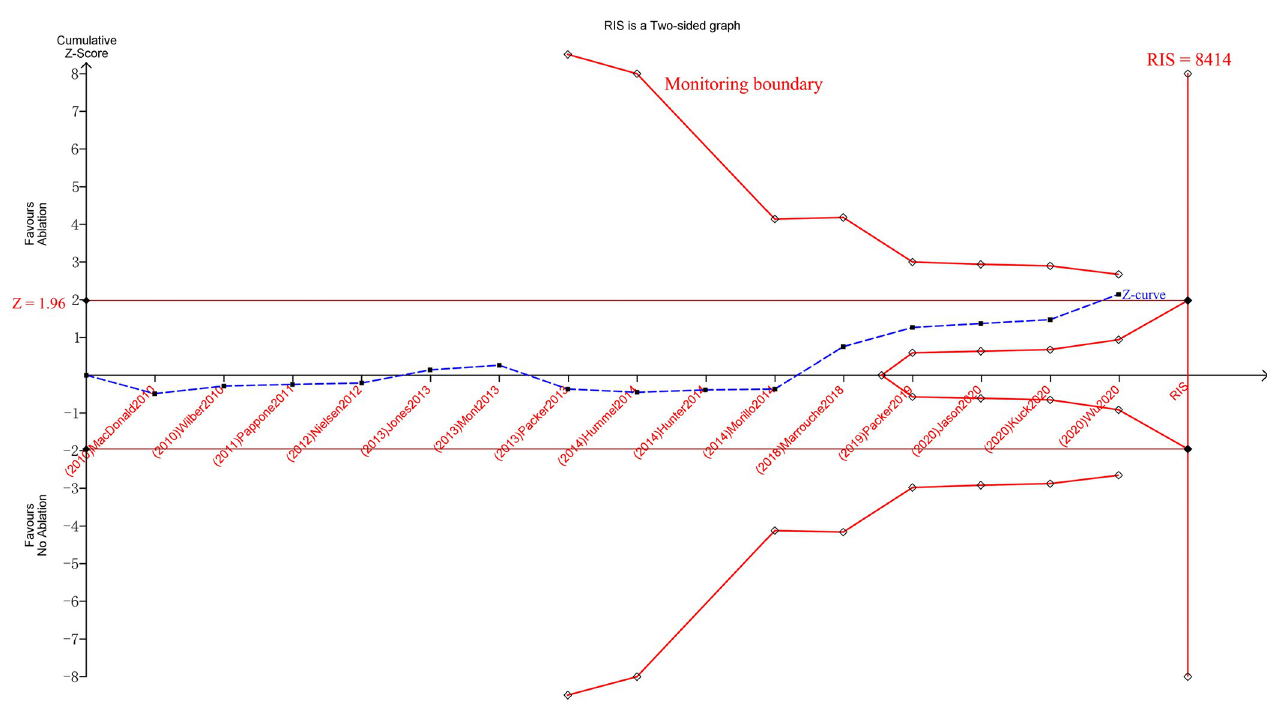
Fig 4. Trial Sequential Analysis (TSA) for stroke/Transient Ischemic Attacks